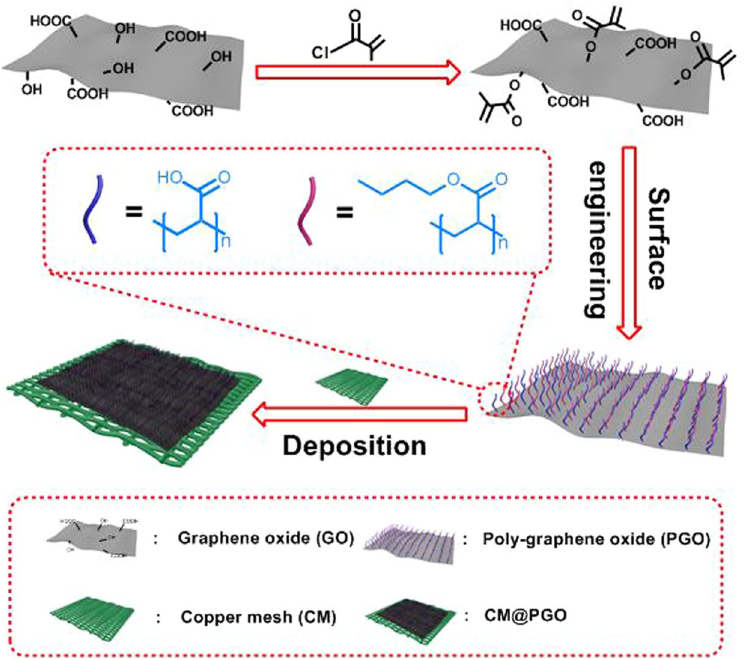
Figure 1. Schematic illustration of CM@PGO synthetic procedure for enriching the local concentration of